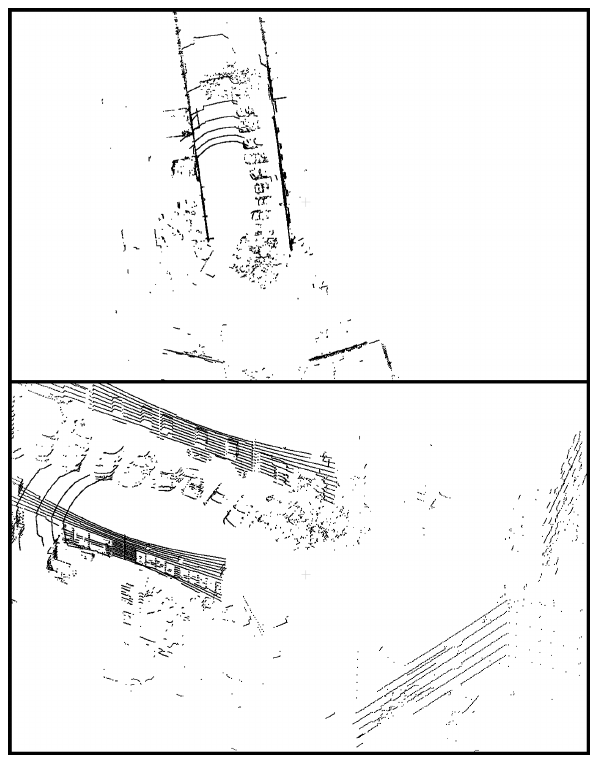
Figure 4. Top (upper) and perspective (lower) view of an example point cloud for a straight street without side roads.